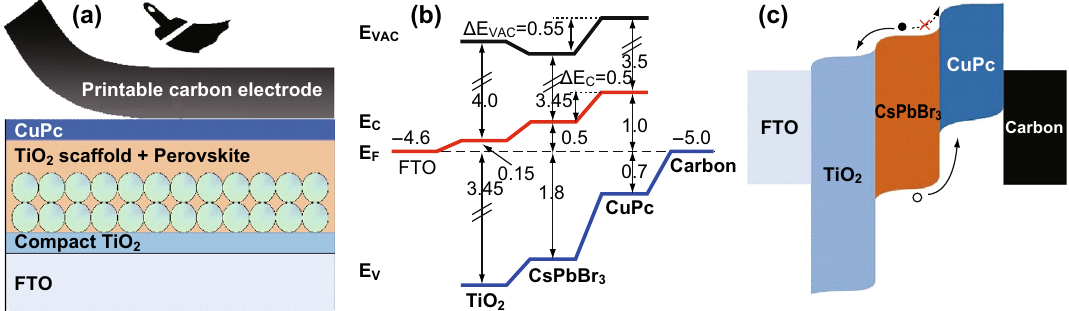
Fig. 1 a Schematic cross-sectional view of the CuPc-based CsPbBr 3 PSC with a printable low-temperature carbon electrode. b Schematic energy-level alignment at interfaces. E VAC is the vacuum energy, E C is the conduction band edges, E F is the Fermi levels, and E V is the valence band edges. c Schematic illustration of proposed band bending at